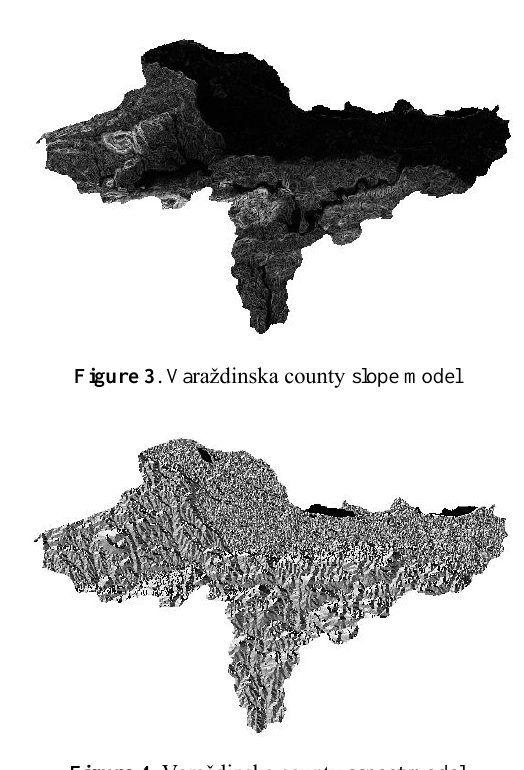
Figure 6 . Suitable solar panels areas for slope